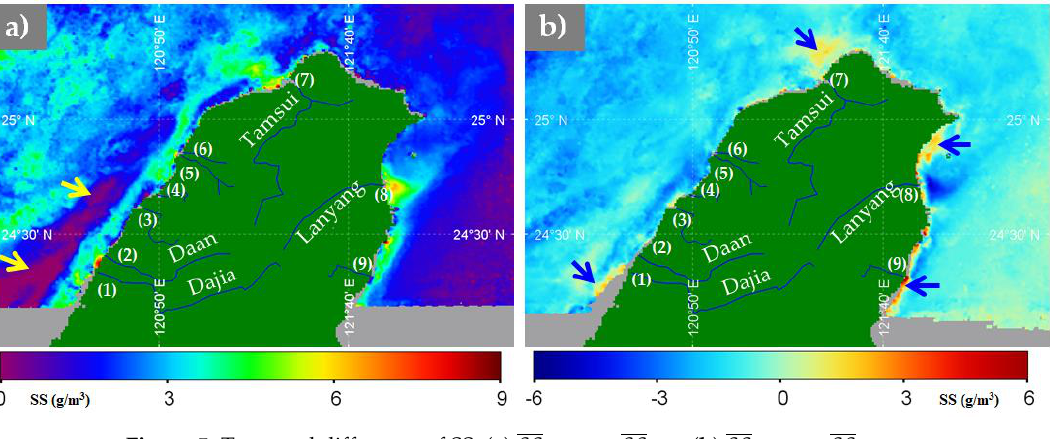
Figure 4. Spatial distribution of SS pre- and post-typhoon: ( a ) SS 4 − 7 ; ( b ) SS 11 − 14 ; ( c ) SS 19 − 22 .